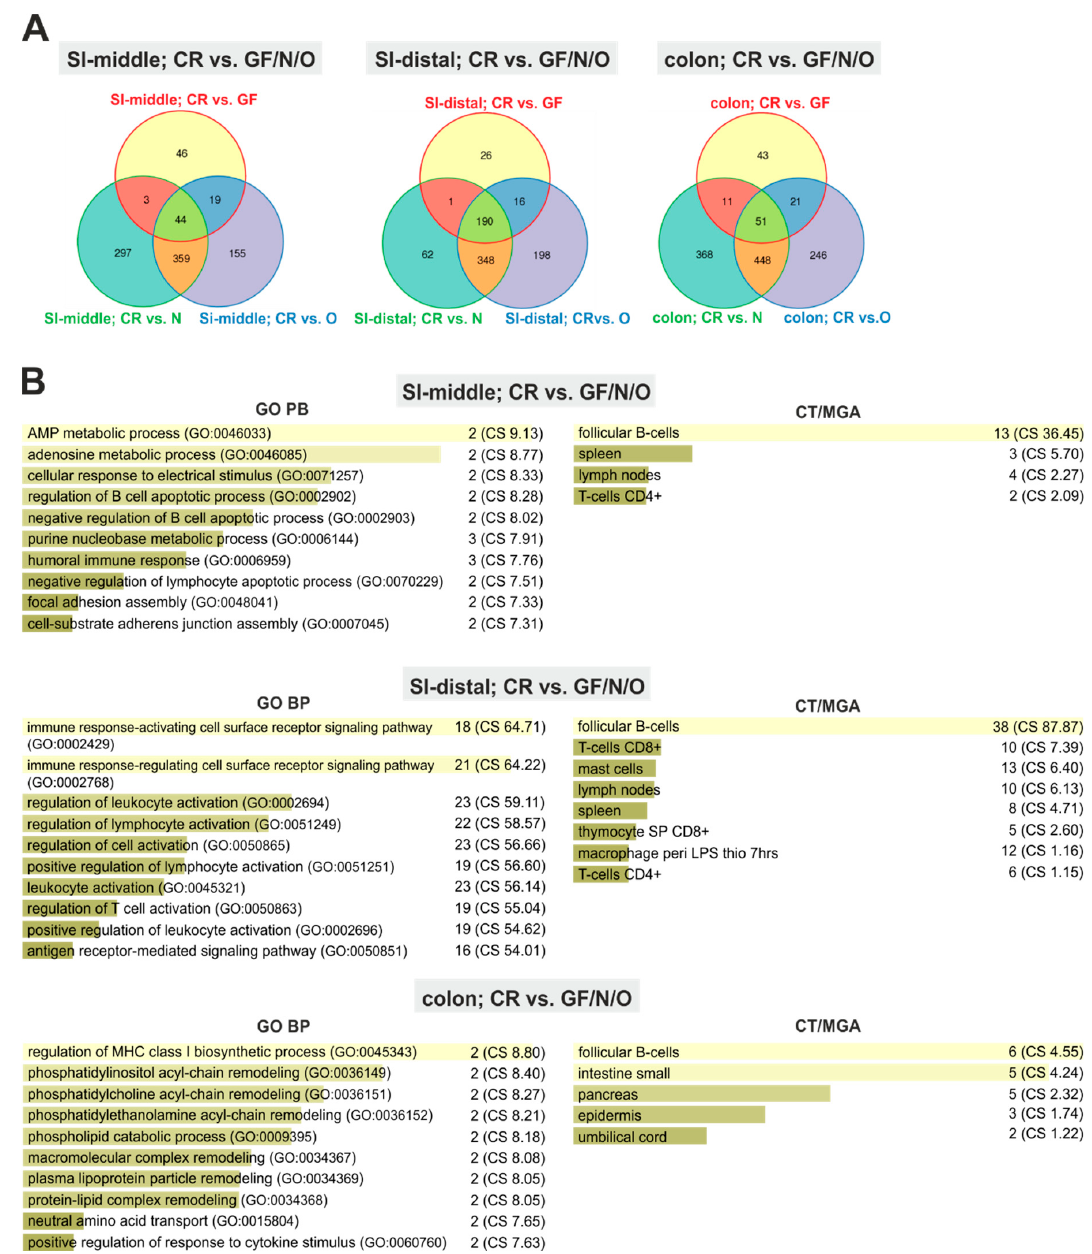
Figure 1. The immune system is not reconstituted upon monoassociation with a single E. coli strain. ( A ) Venn diagrams indicating numbers of gene probes differentially expressed in the middle (SI-middle) and distal (SI-distal) parts of the small intestine and in the colon of GF, N, and O animals when compared with CR mice (significance criterion: q < 0.05; |log FC| ≥ 1). The corresponding annotated genes are listed in Supplementary Table S2. ( B ) Genes expressed differentially in the analyzed groups of mice were analyzed using ‘Gene Ontology Biological Processes’ (GO BPs) and ‘Cell Types/Mouse Gene Atlas’ (CT/MGA) categories in Enricher datasets. The results were sorted according to the combined score (CS; CS is computed by multiplying the log of p -value obtained from the Fisher’s exact test by the z-score of the deviation from the expected rank). A maximum of ten GO BPs and CT/MGA categories containing at least two differentially expressed genes and with CS ≥ 1 is shown; the coloring of the columns corresponds to the significance of the individual columns in the graph. The number of genes in the particular category is indicated by the number before the parenthesis. |log FC|, absolute value of the binary logarithm of relative expression intensity.